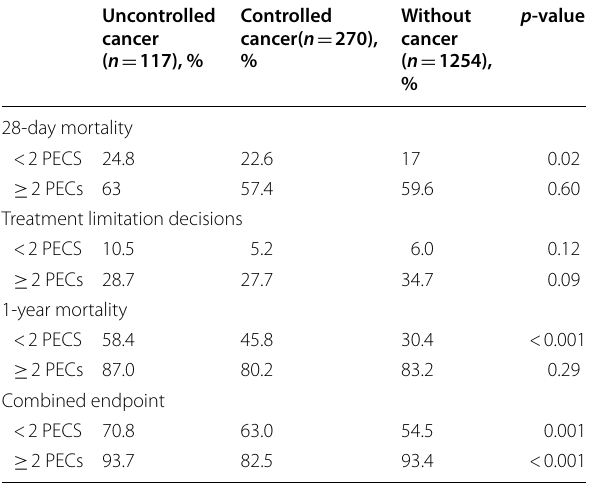
PEC perceptions of excessive care, TLD treatment limitation decisions Combined endpoint: death, poor quality of life or not being at home Patients who were lost to follow-up are not included in this table A p -value of < 0.05 was considered statistically